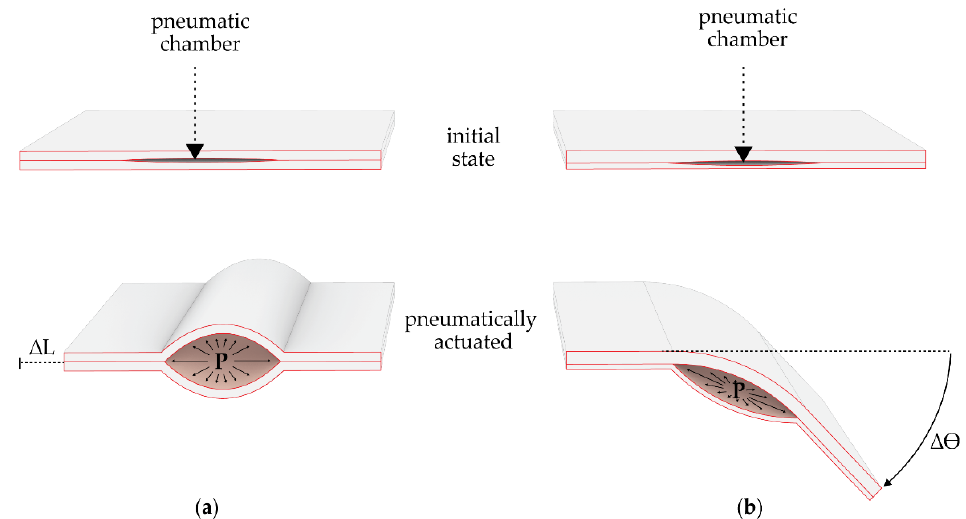
Figure 2. Actuation principle of elements with embedded pneumatic actuators with ( a ) plates with identical stiffness, leading to a shortening in length and ( b ) elements with plates of asymmetrical stiffness causing an angular displacement (adapted from [8]).